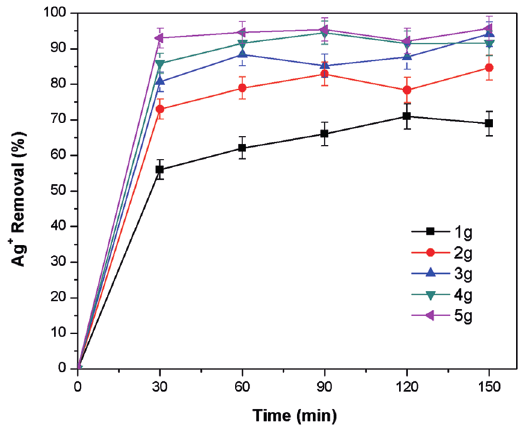
Figure 6: Effects of adsorbent dosage on Ag + ramoval (the weight of MMT: 3% of chitosan solution; pH: 6; Ag + concentration: 10 mg/L; volume: 100 mL; contact time: 150 min).